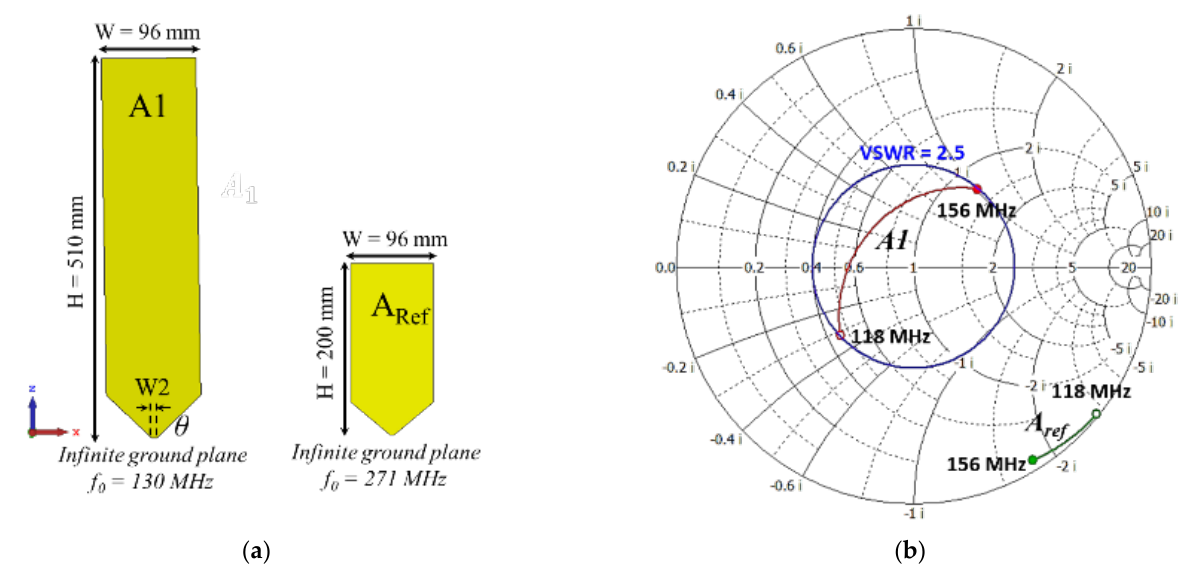
Figure 2. ( a ) Simple monopole antenna A1 of the height of 510 mm, and the reference monopole antenna A Ref of the height of 200 mm. ( b ) Smith chart of the antenna’s impedances in the band 118 to 156 MHz.